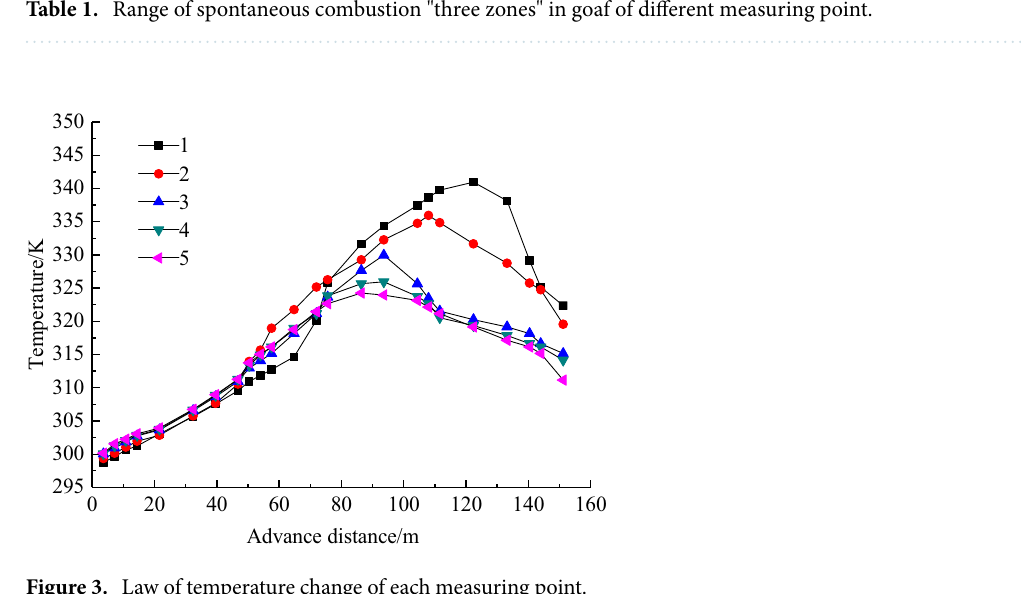
Table 1. Range of spontaneous combustion "three zones" in goaf of different measuring point.